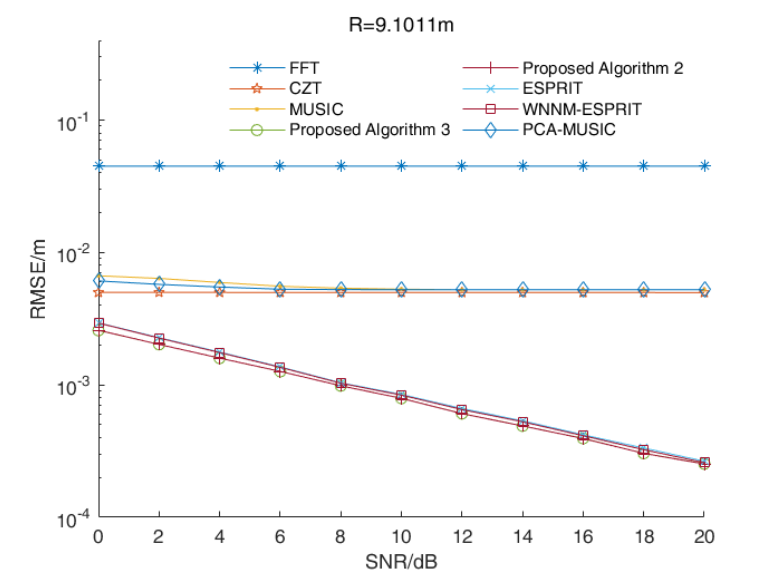
Figure 6. The RMSE values of the distance estimations versus the SNR values of various algorithms in a single-target